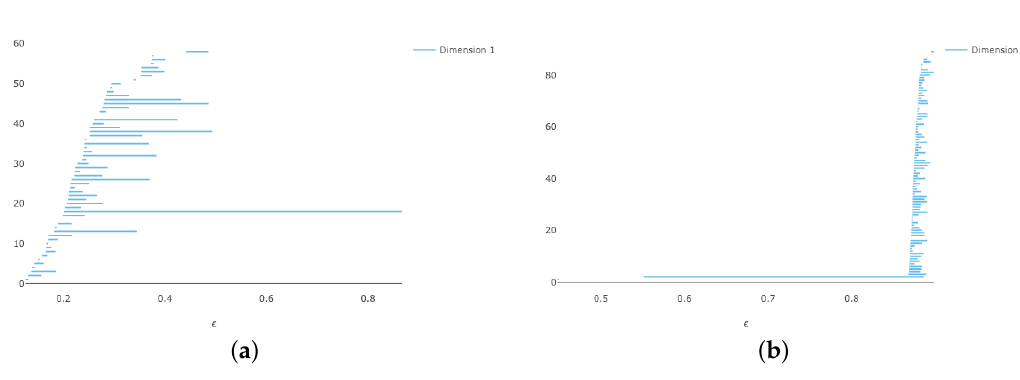
Figure 6. Vietoris–Rips persistence diagrams for 200 points on R P 2 , using the isometric embedding into R 5 ( a ) H 1 persistence and ( b ) H 2 persistence.